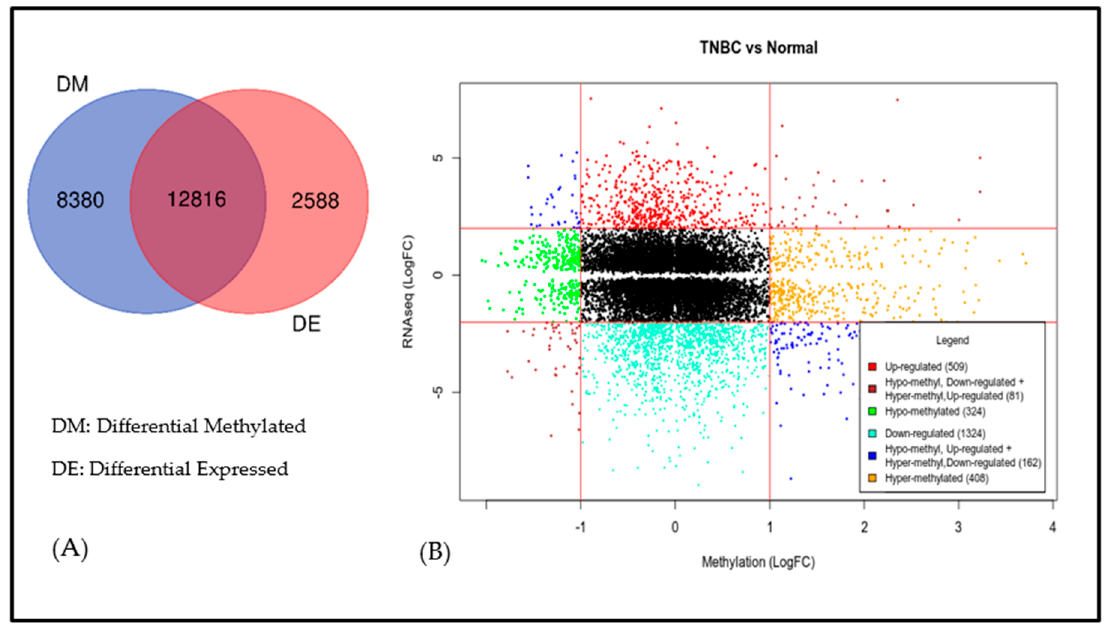
Figure 2. Signature of aberrantly methylated and di ff erentially expressed genes transcriptionally associated with triple-negative breast cancer (TNBC). ( A ) Venn diagram representing genes significantly di ff erentially expressed and significantly di ff erentially methylated between tumors and controls. The intersection shows genes containing both genomic and epigenomic alterations and are associated with TNBC. ( B ) Two-way Starburst plot showing di ff erentially expressed genes (y-axis) and di ff erentially methylated genes (x-axis). The colors represent direction of change and activity as represented in the Figure legend.